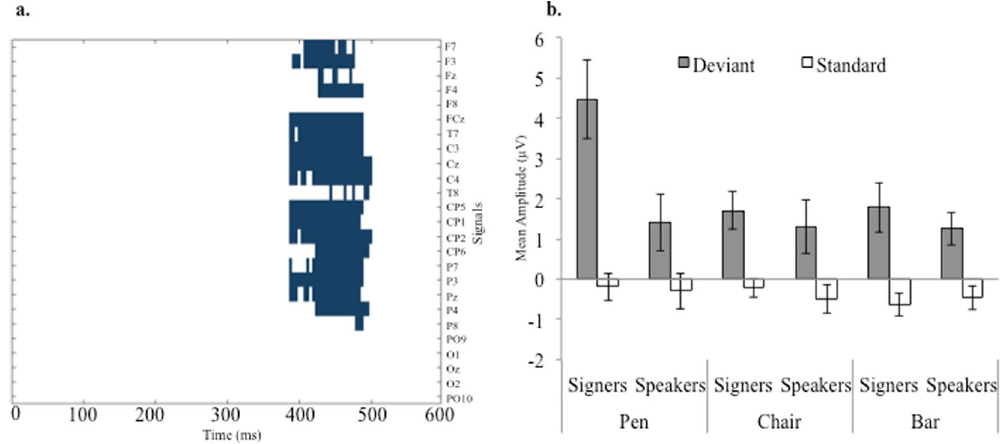
Figure 4. Panel (a) Cluster-based permutative analysis were conducted to determine the electrode clusters and the time window in which the deviancy effect (deviant minus standard) occurred. Regions in which the deviancy effect was significantly larger (p < 0.05) for signers than speakers are shown in blue. A significant effect was found only for pen, which concentrated in the P300 temporal region. (The non-significant results from chair and bar are not shown). Panel (b) Mean amplitudes elicited by standards and deviants over the Pz electrode between 250 and 550 ms post stimulus-onset (P300). For each type of stimuli (pen, chair, and bar), orientation change elicited a significant deviancy effects (i.e., larger positive amplitudes for deviants). However, only for pen the deviancy effect was a significantly larger for signers than speakers. Error bars indicate standard errors.